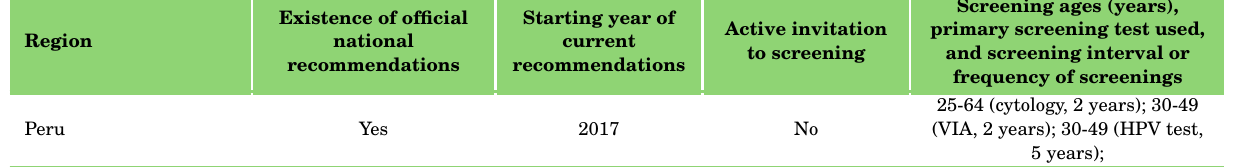
Table 45: Main characteristics of cervical cancer screening in